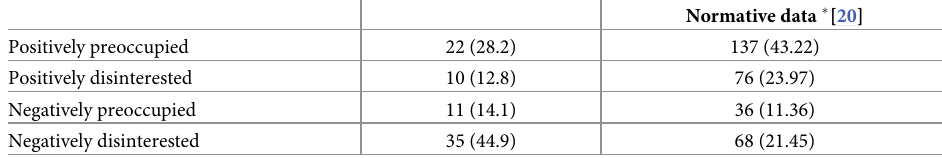
Table 3. Comparative maternal attachment styles, n (%).